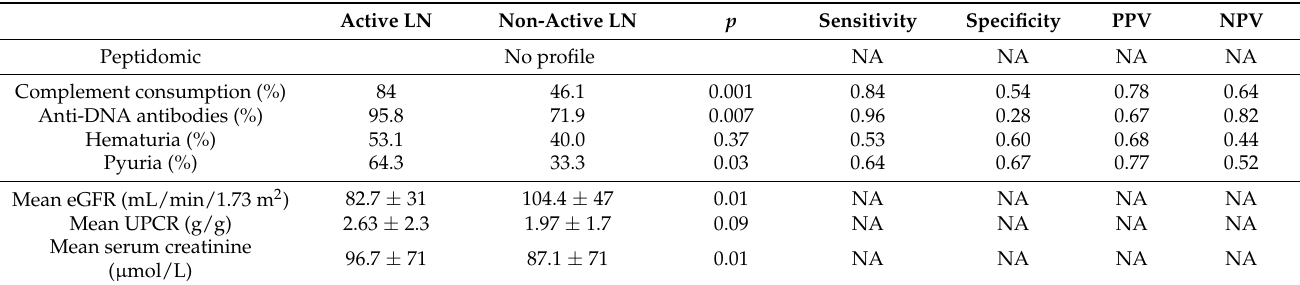
Table 3. Comparison of biological parameters between patients with active and non-active lupus nephritis and discrimina- tive power of routine SLE